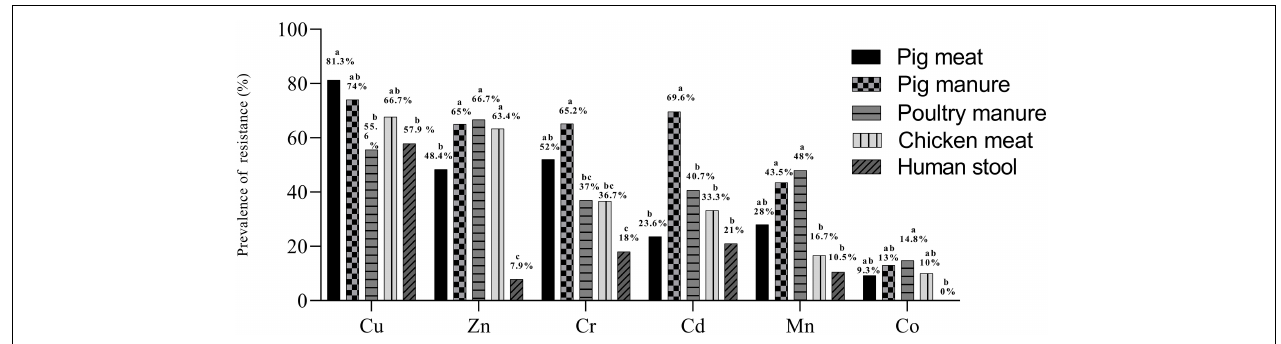
FIGURE 2 | Prevalence of resistance to Cu, Zn, Mn, Cd, Co, and Cr among Salmonella Typhimurium isolates from pig meat, pig manure, poultry manure, chicken meat, and human stool. Different lowercase letters indicate statistically significant differences between groups ( P < 0.05).